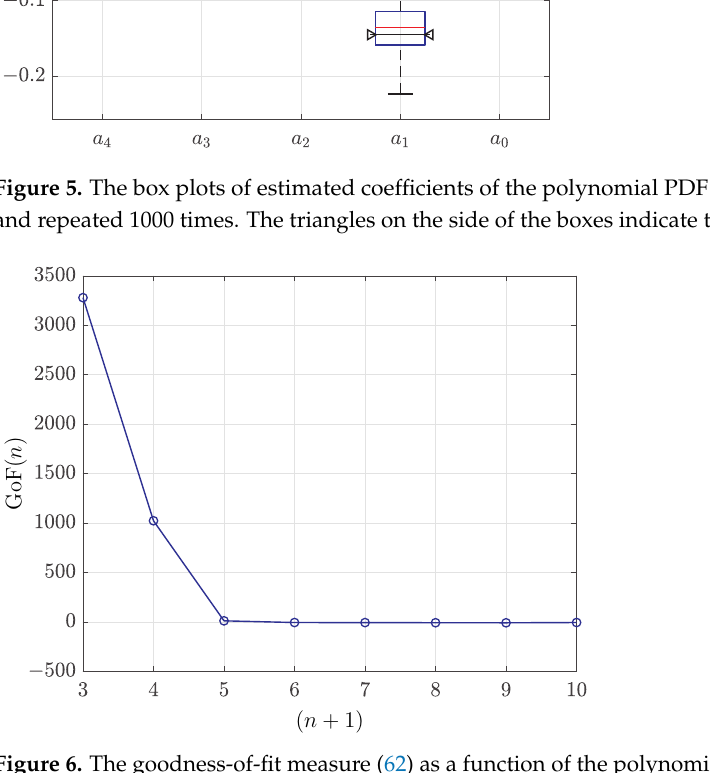
Figure 6. The goodness-of-fit measure (62) as a function of the polynomial order, n